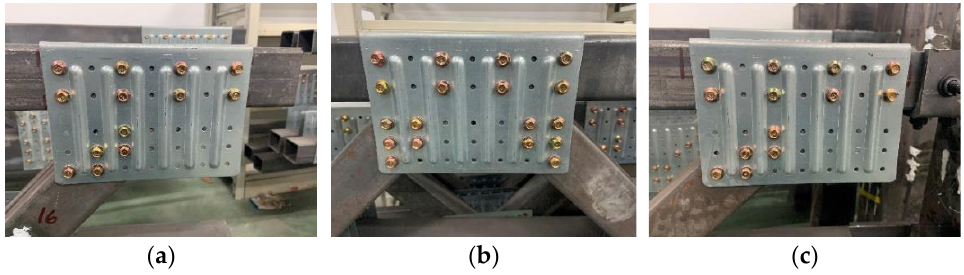
Figure 4. Connection details between the U connectors and the truss-beam members for specimens named JU60. ( a ) Node at free end of the beam, ( b ) node in the middle, ( c ) node adjacent to the column.